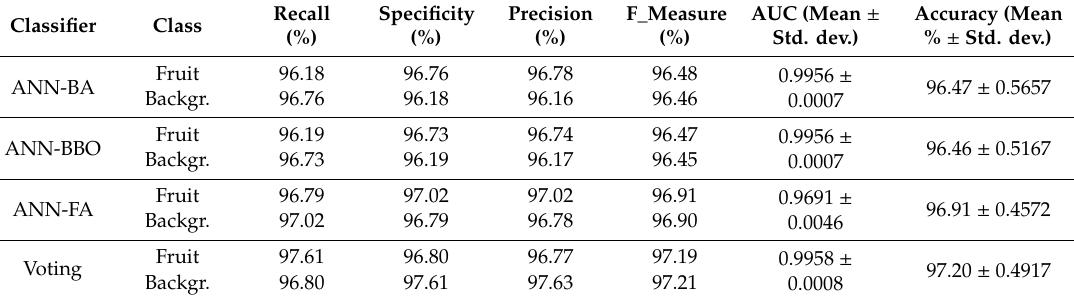
Table 13. The performance of di ff erent classifiers based on di ff erent criteria for 500